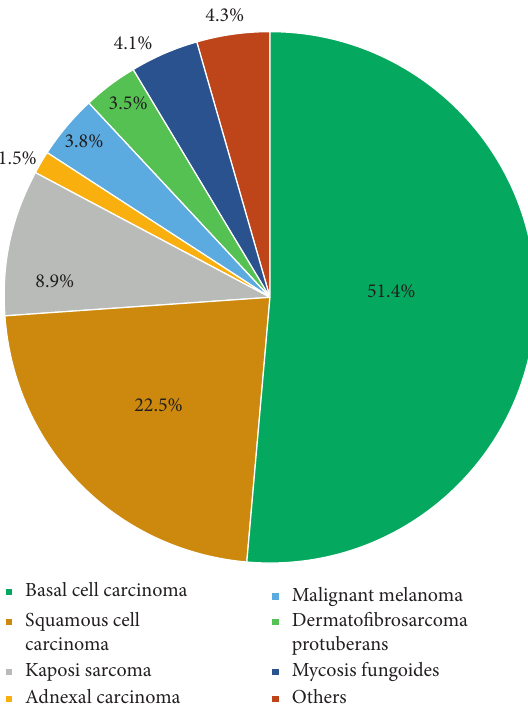
Figure 4: Pie chart summary of the pooled proportion for the prevalence malignant